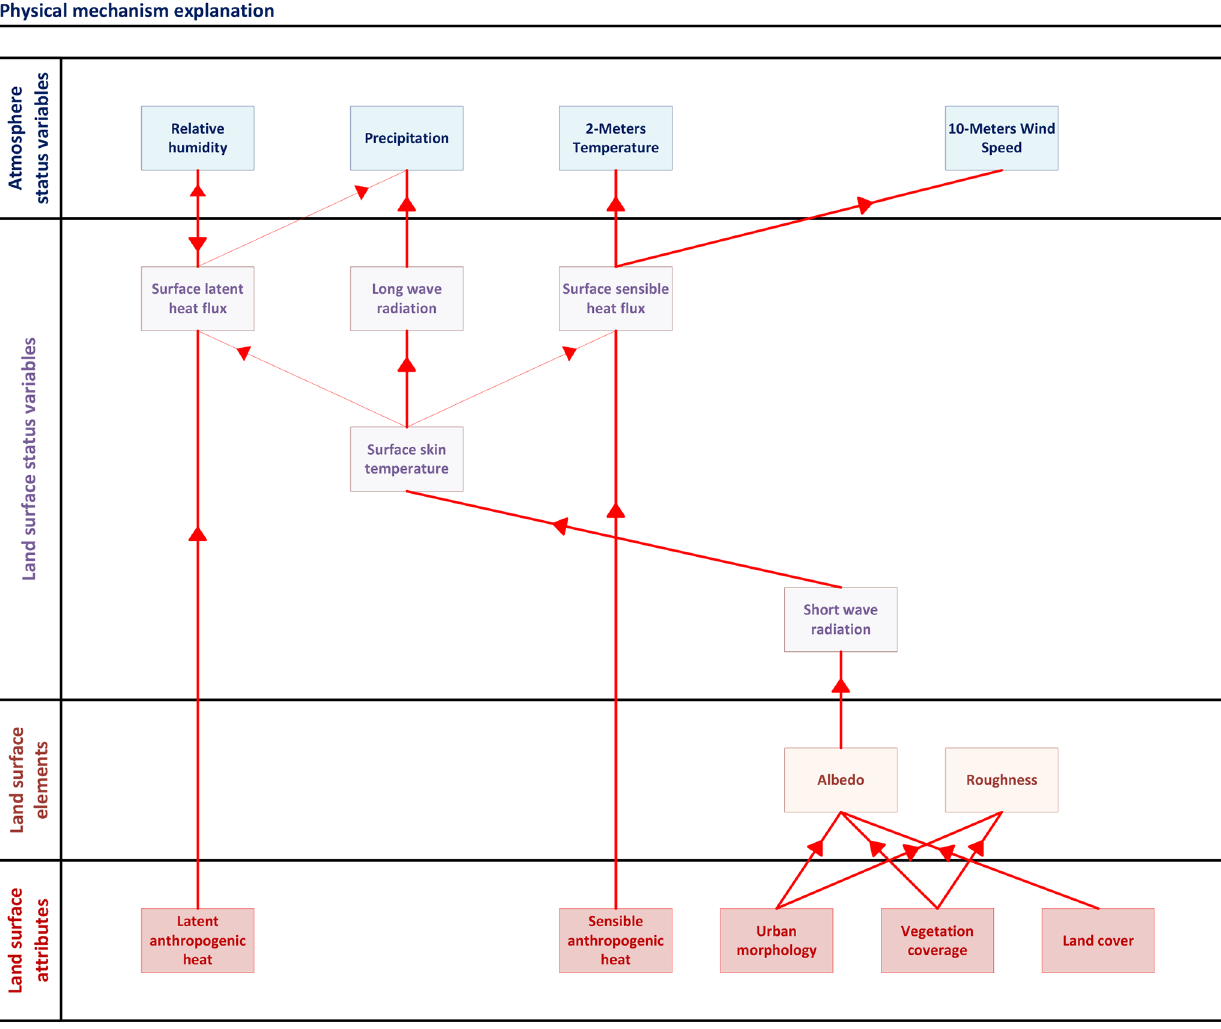
Figure 11. The mechanism in propagating the detailed spatial features from the land surface attributes to the atmospheric